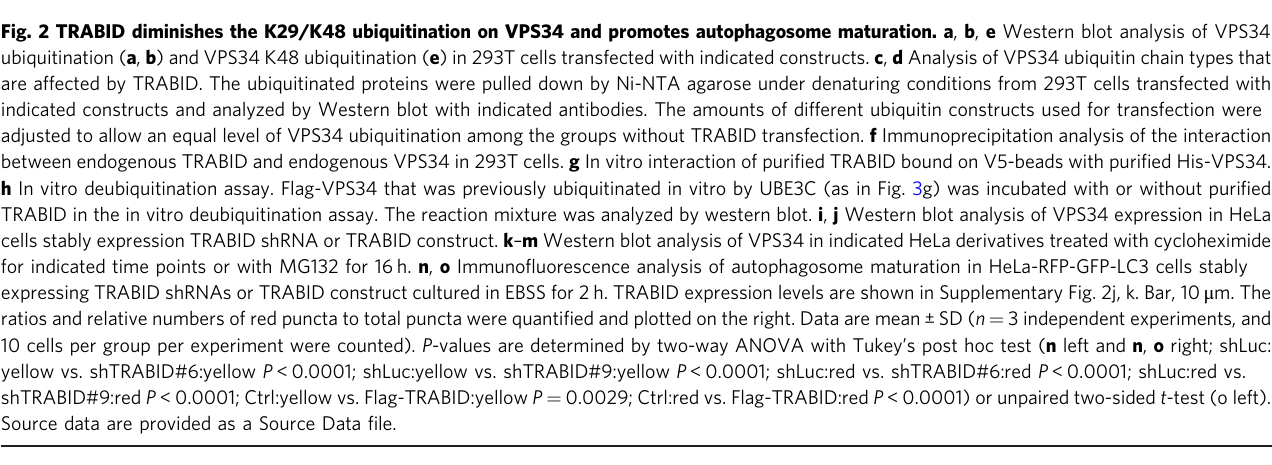
Fig. 2 TRABID diminishes the K29/K48 ubiquitination on VPS34 and promotes autophagosome maturation. a , b , e Western blot analysis of VPS34 ubiquitination ( a , b ) and VPS34 K48 ubiquitination ( e ) in 293T cells transfected with indicated constructs. c , d Analysis of VPS34 ubiquitin chain types that are affected by TRABID. The ubiquitinated proteins were pulled down by Ni-NTA agarose under denaturing conditions from 293T cells transfected with indicated constructs and analyzed by Western blot with indicated antibodies. The amounts of different ubiquitin constructs used for transfection were adjusted to allow an equal level of VPS34 ubiquitination among the groups without TRABID transfection. f Immunoprecipitation analysis of the interaction between endogenous TRABID and endogenous VPS34 in 293T cells. g In vitro interaction of puri fi ed TRABID bound on V5-beads with puri fi ed His-VPS34. h In vitro deubiquitination assay. Flag-VPS34 that was previously ubiquitinated in vitro by UBE3C (as in Fig. 3g) was incubated with or without puri fi ed TRABID in the in vitro deubiquitination assay. The reaction mixture was analyzed by western blot. i , j Western blot analysis of VPS34 expression in HeLa cells stably expression TRABID shRNA or TRABID construct. k – m Western blot analysis of VPS34 in indicated HeLa derivatives treated with cycloheximide for indicated time points or with MG132 for 16 h. n , o Immuno fl uorescence analysis of autophagosome maturation in HeLa-RFP-GFP-LC3 cells stably expressing TRABID shRNAs or TRABID construct cultured in EBSS for 2 h. TRABID expression levels are shown in Supplementary Fig. 2j, k. Bar, 10 μ m. The ratios and relative numbers of red puncta to total puncta were quanti fi ed and plotted on the right. Data are mean ± SD ( n = 3 independent experiments, and 10 cells per group per experiment were counted). P -values are determined by two-way ANOVA with Tukey ’ s post hoc test ( n left and n , o right; shLuc: yellow vs. shTRABID#6:yellow P < 0.0001; shLuc:yellow vs. shTRABID#9:yellow P < 0.0001; shLuc:red vs. shTRABID#6:red P < 0.0001; shLuc:red vs. shTRABID#9:red P < 0.0001; Ctrl:yellow vs. Flag-TRABID:yellow P = 0.0029; Ctrl:red vs. Flag-TRABID:red P < 0.0001) or unpaired two-sided t -test (o left). Source data are provided as a Source Data fi